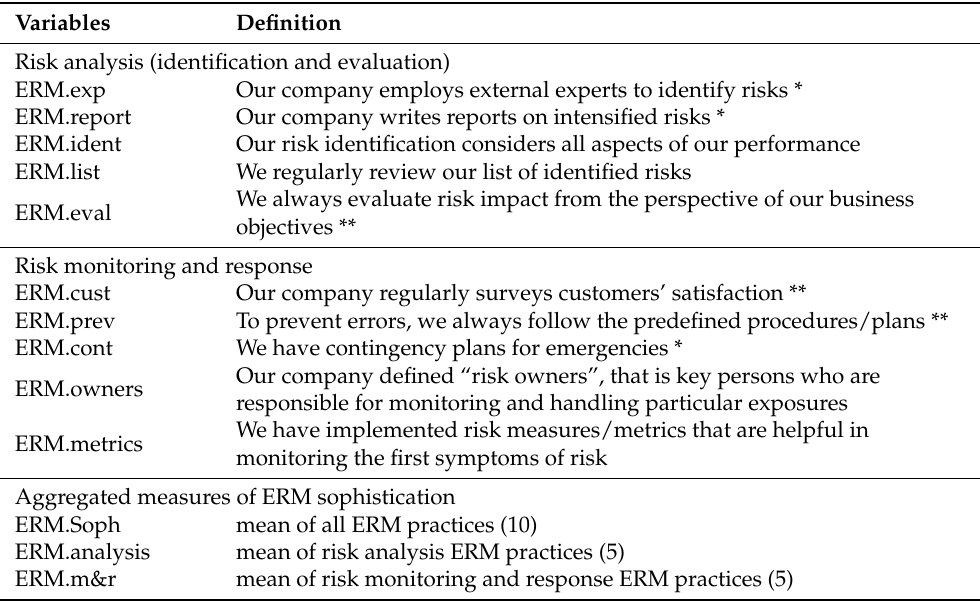
Table 2. The variables and the related survey questions in ERM sophistication